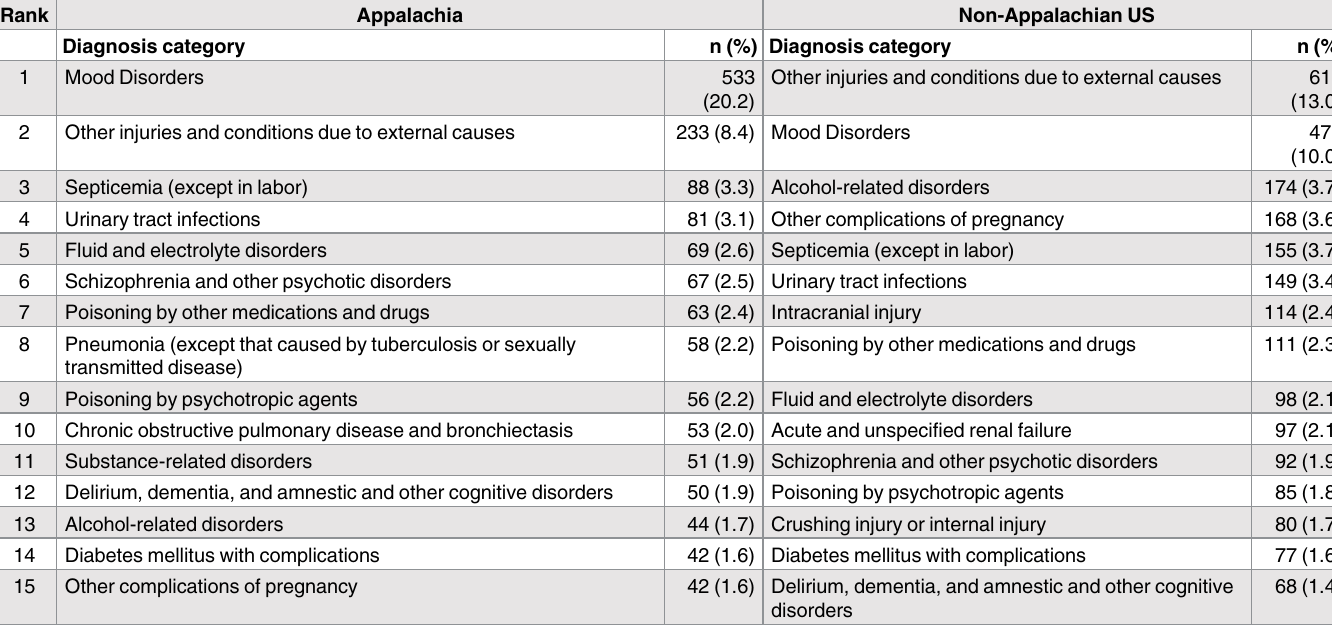
Table 3. Top fifteen comorbid diagnoses for IPV-related hospitalizations in Appalachia and non-Appalachian counties in the US, 2007–2011.